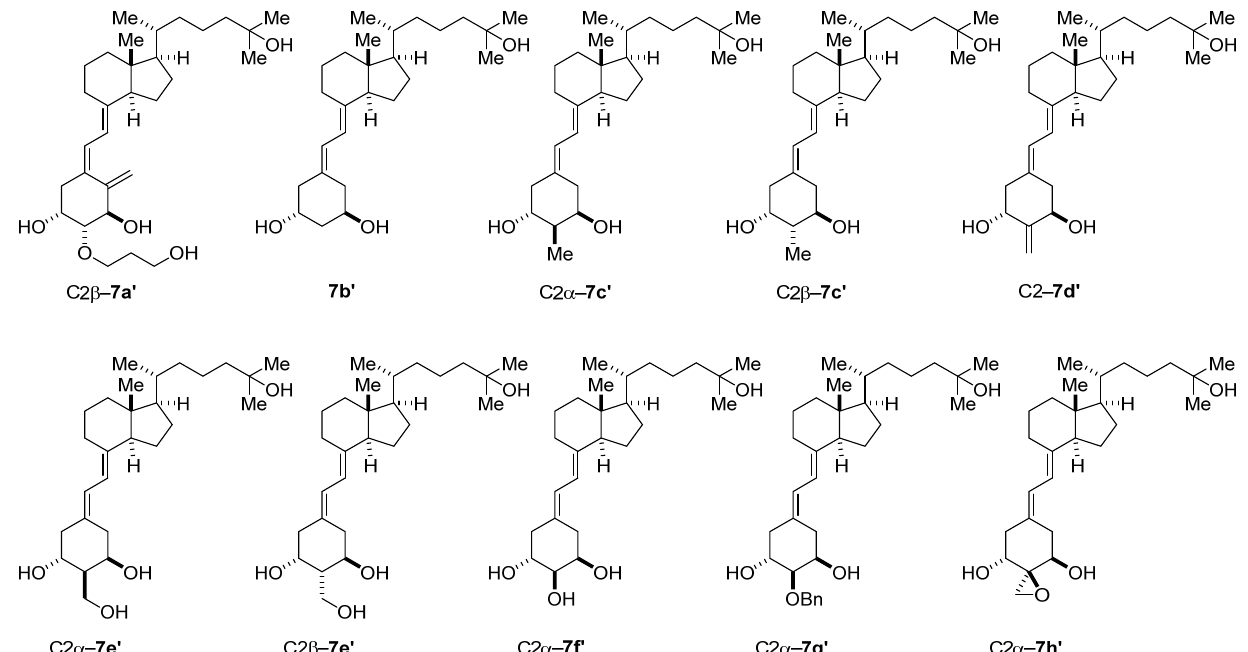
Figure 1. Structures of 19-nor type vitamin D derivatives substituted at C2.